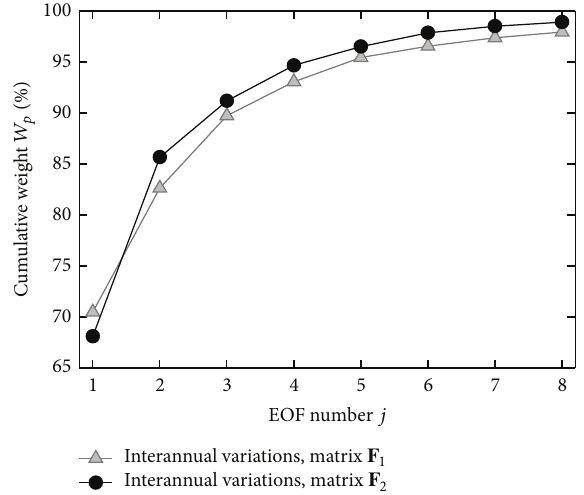
Figure 3: Cumulative weight 𝑊 𝑝 of the EOFs found for both cases of temperature anomalies and subject of the present